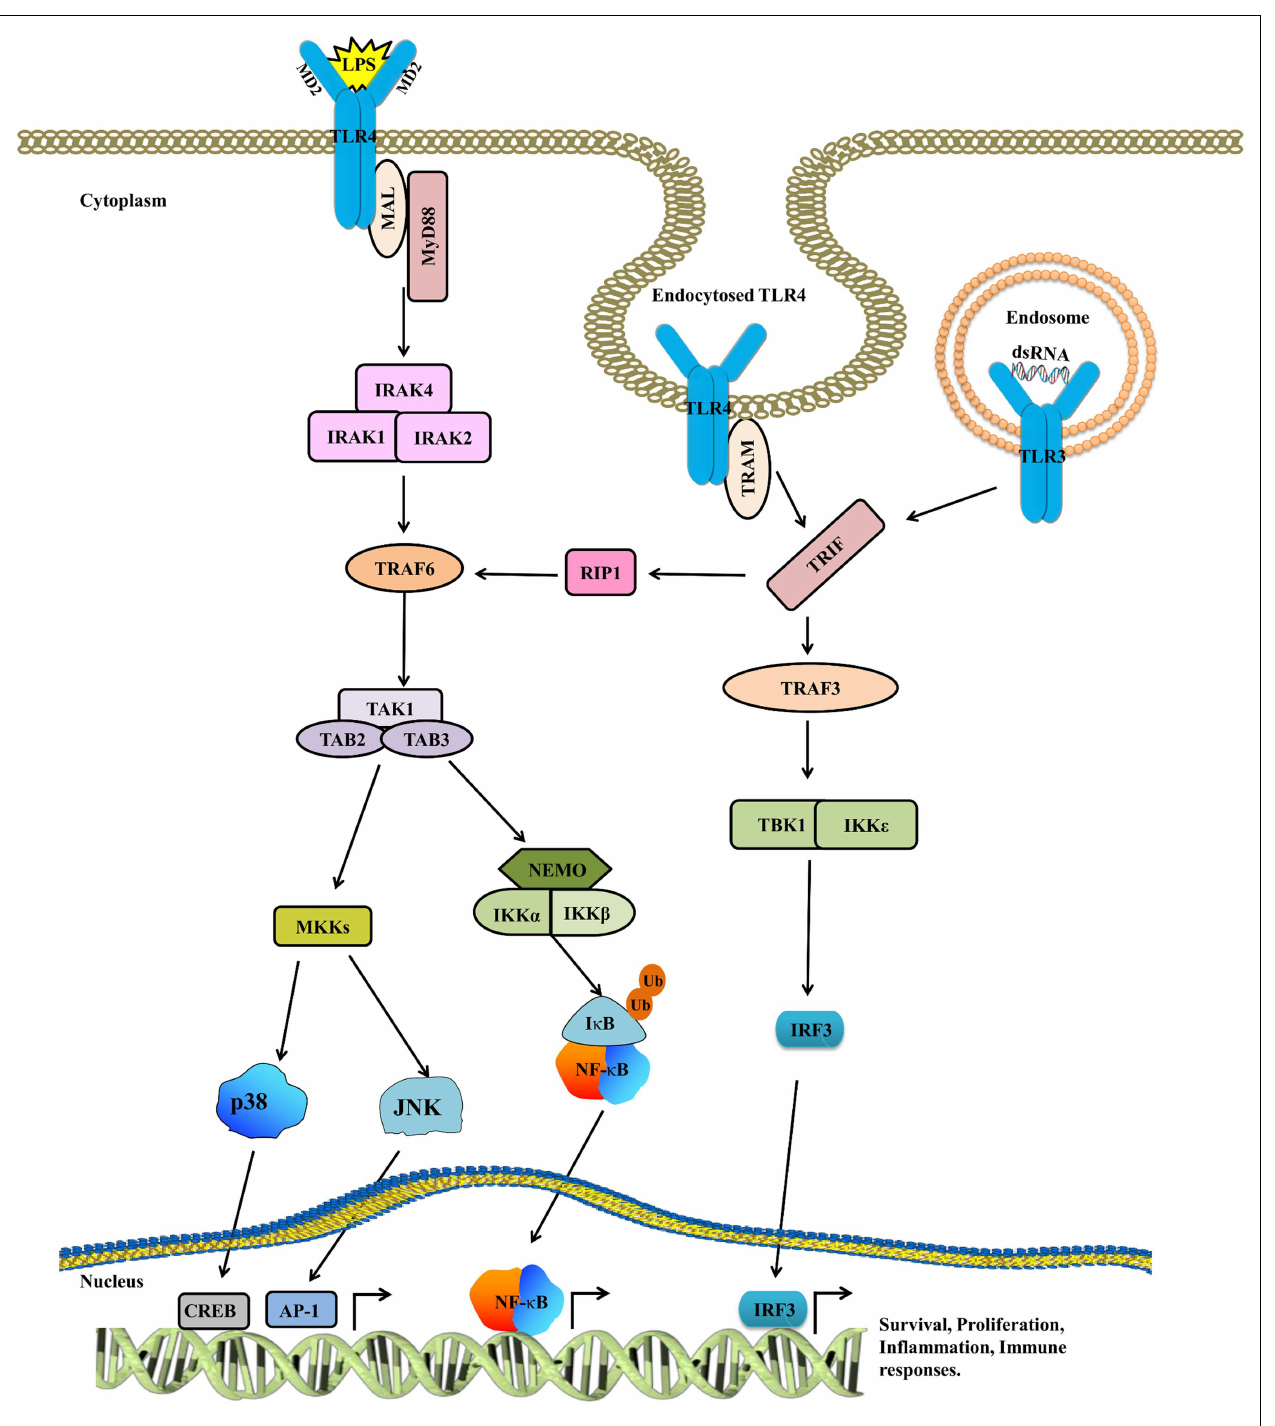
complex is maintained in the inactive state by I κ B, which is in turn degraded by proteasomes, resulting in the translocation of NF- κ B into the nucleus. Besides activating NF- κ B,TAK1 also phosphorylates MAPKs to further reinforce the inflammatory response.TheTRIF/TRAM pathway not only activates NF- κ B but also triggers IRF3 to mount an antiviral response. Cumulatively, all these signaling pathways assist in eradicating infection as well as play an important role in sustaining the normal physiological functions in